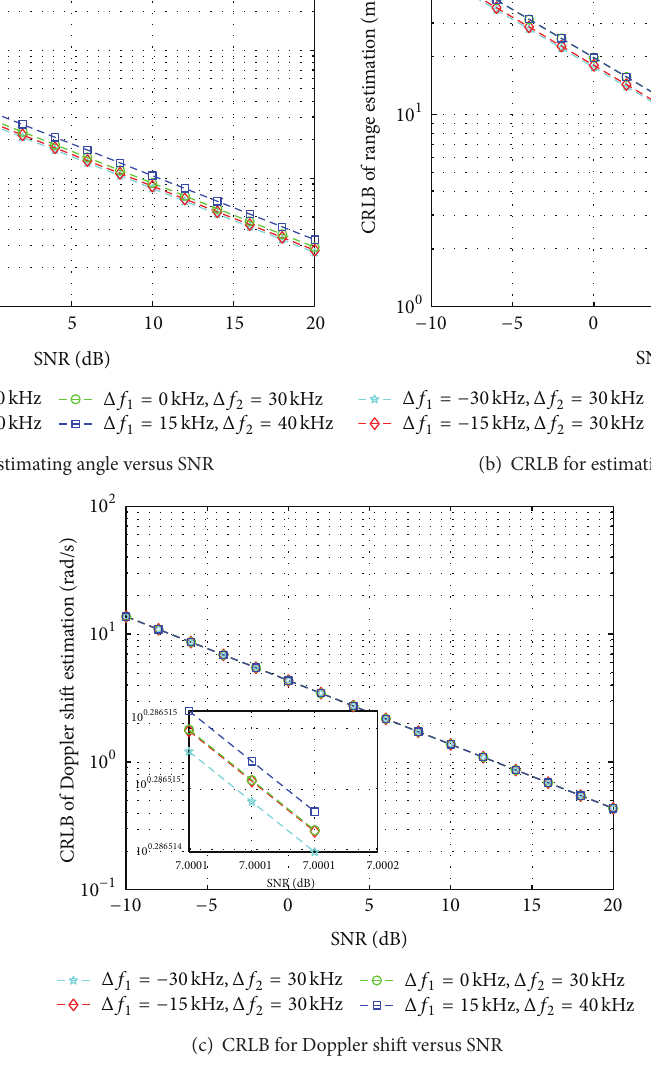
Figure 8: General CRLB results of TS-FDA radar with 𝑀 = 32